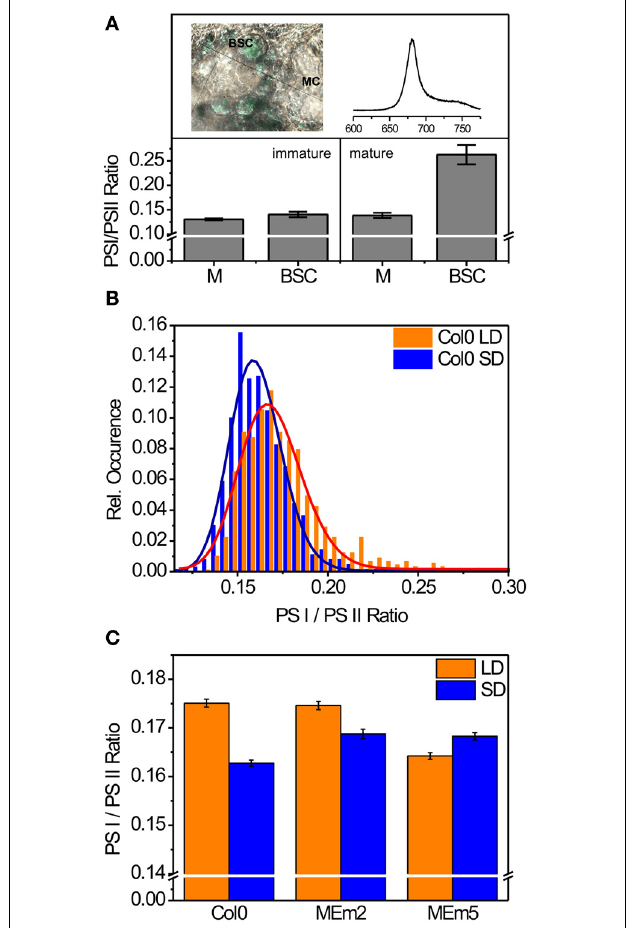
FIGURE 2 | PSI/PSII ratio in chloroplasts of living plant cells determined by SART. (A) Average PSI/PSII ratio of chloroplasts in immature maize leaf tissue [left; calculated from 19 spectra recorded from mesophyll cells (MC) and 19 spectra recorded in bundle sheath cells (BSC), ( n = 38, p = 0 . 1)] and in mature leaf tissue (right; calculated from 38 spectra recorded in MC and 59 spectra recorded in BSC). The upper left shows a brightfield image of a maize leaf section with MS and BSC cells. The upper right depicts a typical fluorescence intensity spectrum recorded from MC (x axis: emission wavelength [nm]). (B) Histogram of the calculated PSI/PSII intensity ratio of A. thaliana grown under long day (LD) and short day (SD) conditions. The histograms were calculated from 893 spectra in case of LD plants and 630 spectra in case of SD conditions. The histograms were fit with lognormal model functions with an adjusted R 2 -value of at least 0.95 (solid lines). (C) Average PSI/PSII intensity ratios in chloroplasts of A. thaliana wild type (Col0) and transgenic plants expressing maize plastidic NADP malic enzyme at different levels (MEm2 and MEm5 plants with 6 and 33 times increased NADP ME activity with regards to the wild type, respectively) grown under short day (SD) or long day (LD)